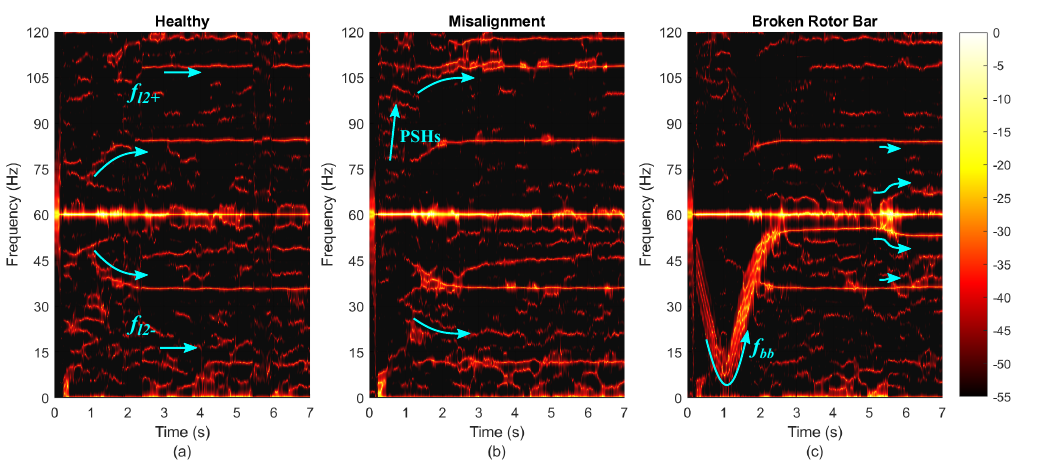
Figure 6. Min-Norm ( t , f ) analysis of the starting current with the line-fed induction motor driving a rated load, for the case of: ( a ) Healthy motor. ( b ) Mechanical misalignment. ( c ) Motor with one broken rotor